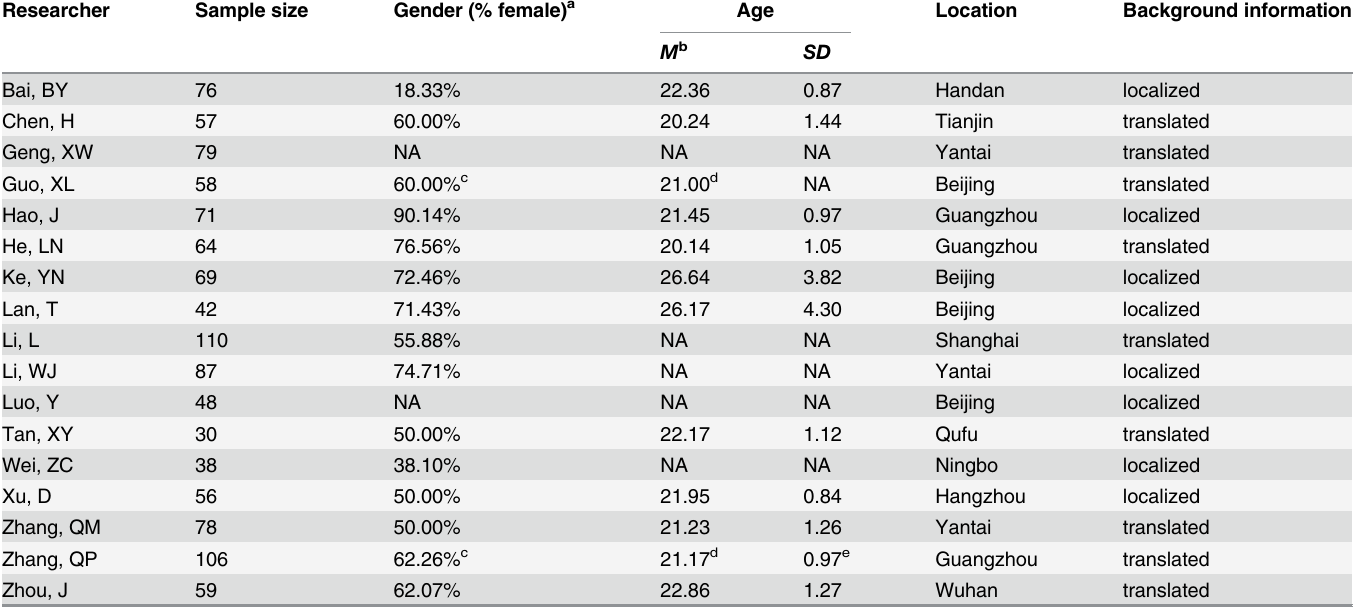
a The gender ratio was calculated after missing values in the study were replaced. b The mean age was calculated after missing values in the study were replaced. c Only gender ratio of the sample was provided without participant-level data. d Only the mean age of the sample was provided without participant-level data. e Only the SD of the sample was provided without participant-level